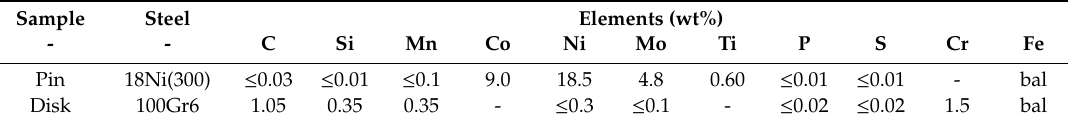
Figure 1. ( a ) The pin-on-disk tester; ( b ) a schematic illustration of the tester. Table 1. Chemical compositions of pin and disk